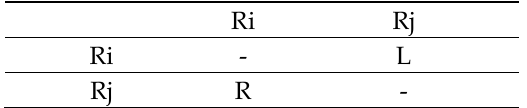
Figure 4. UNL graph of two nodes with the common parent.